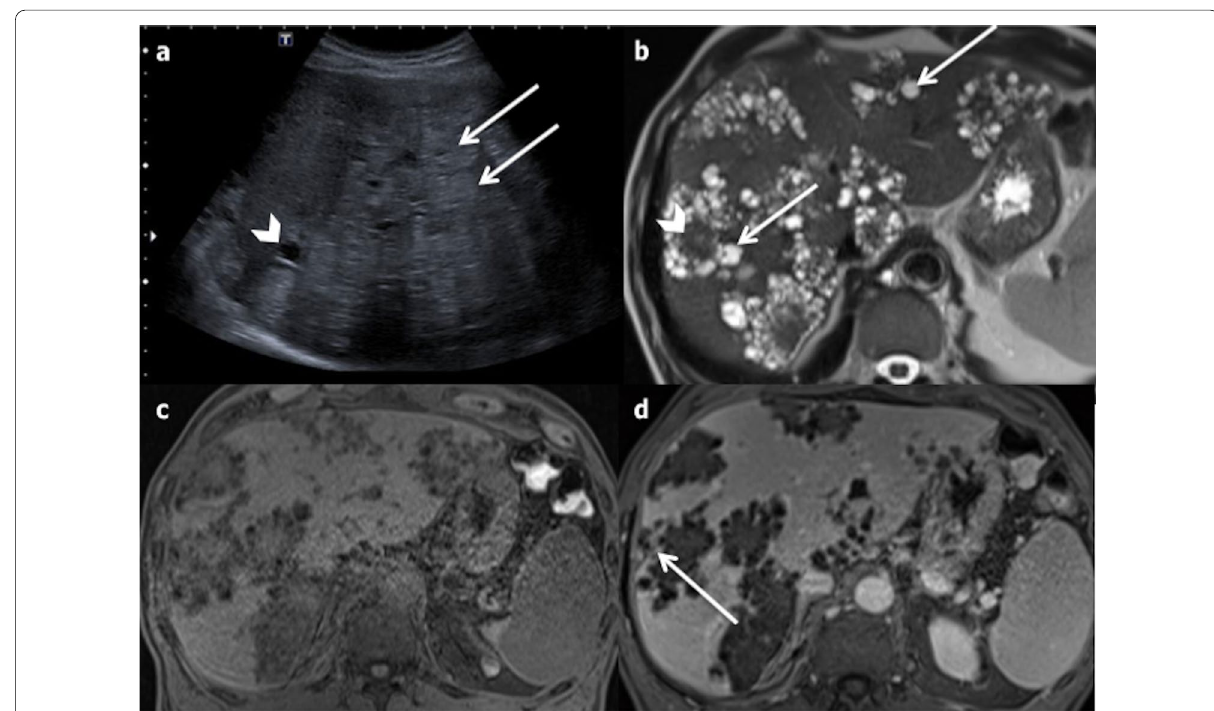
Fig. 30 Hepatic alveolar echinococcosis in a 40-year-old male. a Ultrasonography shows multiple round hyperechoic nodules (arrows) with cystic anechoic parts (arrowhead). b On Axial T2-weighted magnetic resonance imaging, the lesions appear as multivesicular cystic masses (arrows) with a fibrous component (arrowhead). c and d On axial non-enhanced T1-fat-sat-weighted magnetic resonance imaging, the fibrous part is enhancing on late phase